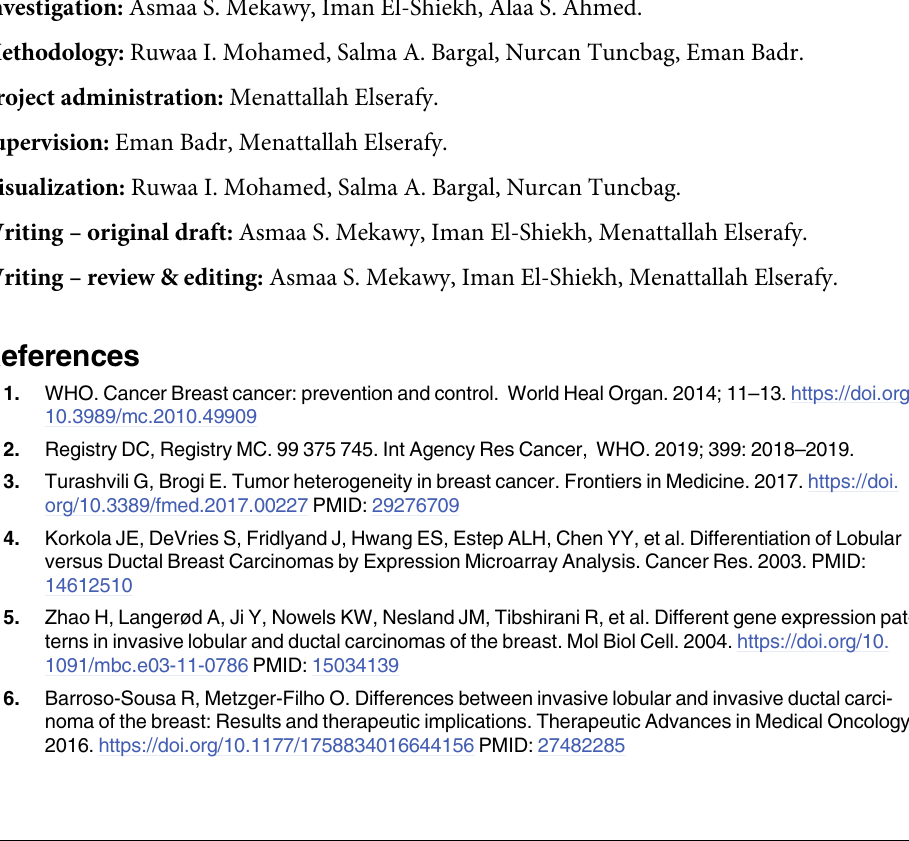
S6 Table. DEMs in IDC vs Normal_Ductal. The positive log2 fold change reflects overexpres- sion in IDC when compared to Normal_ductal, and the negative values reflect the downregu- lation in IDC in comparison to Normal_ductal. S7 Table. DEMs in IDC vs LC. The positive log2 fold change reflects overexpression in IDC when compared to LC, and the negative values reflect the downregulation in IDC in compari- son to LC. S8 Table. Simple somatic mutations and copy number variations in the TCGA-BRCA proj- ect